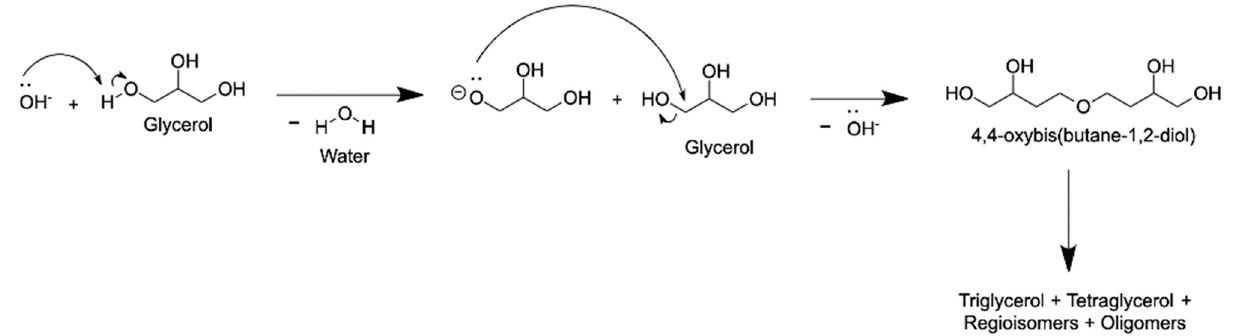
Figure 19. Reaction mechanism for solvent-free glycerol etherification with basic catalysts [132].